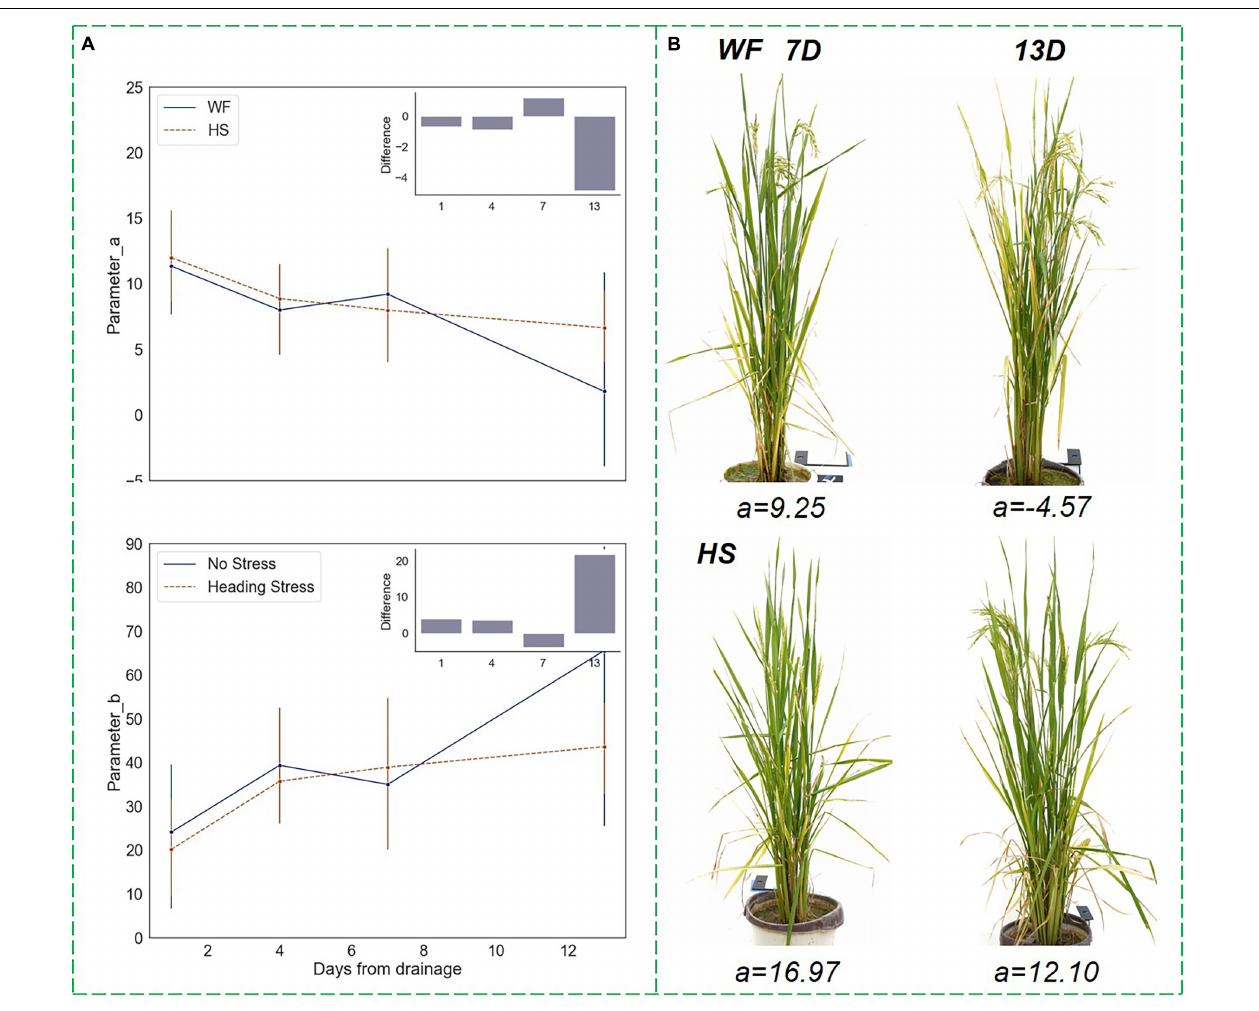
FIGURE 9 | Changing trends of parameters in the vertical distribution function under short-term water stress during the heading stage. (A) Parameters a and b trends. (B) Changes in the front-view image within 7–13 days after drought, where the upper images showed the plants in the WF group, and the lower images showed the plants in the HS